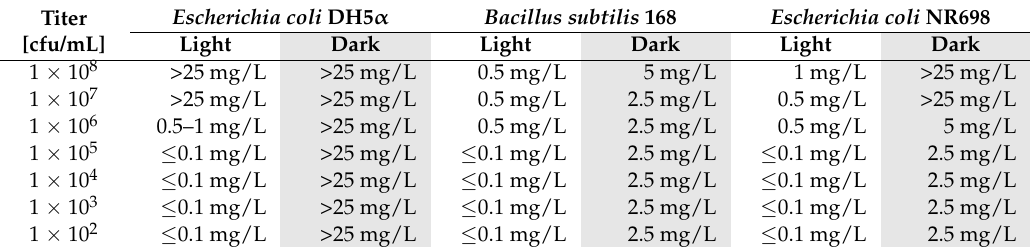
Table 2. MIC values of chlorophyllin extracted from spinach against Gram-negative and Gram-positive model strains. The exposure time to chlorophyllin was 24 h at 37 ◦ C in LB. MICs were determined in light (total light dose: ~1000 J/cm 2 , bright columns) or darkness (grey columns).